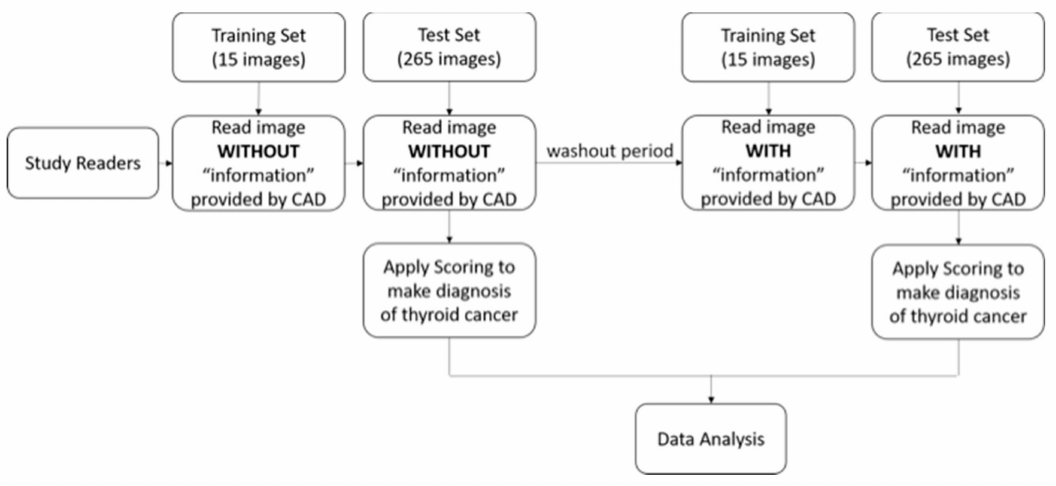
The flowchart for evaluating the reader performance testing of computer-aided detection